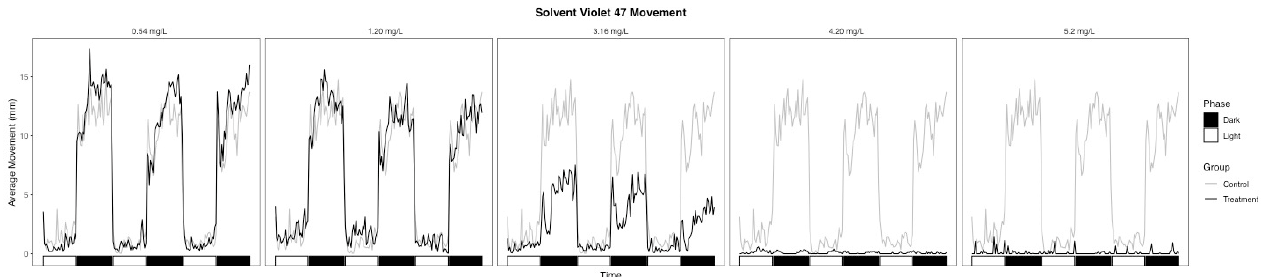
Figure 3. Average movement of Solvent Violet 47 treatment groups throughout the photomotor assay.